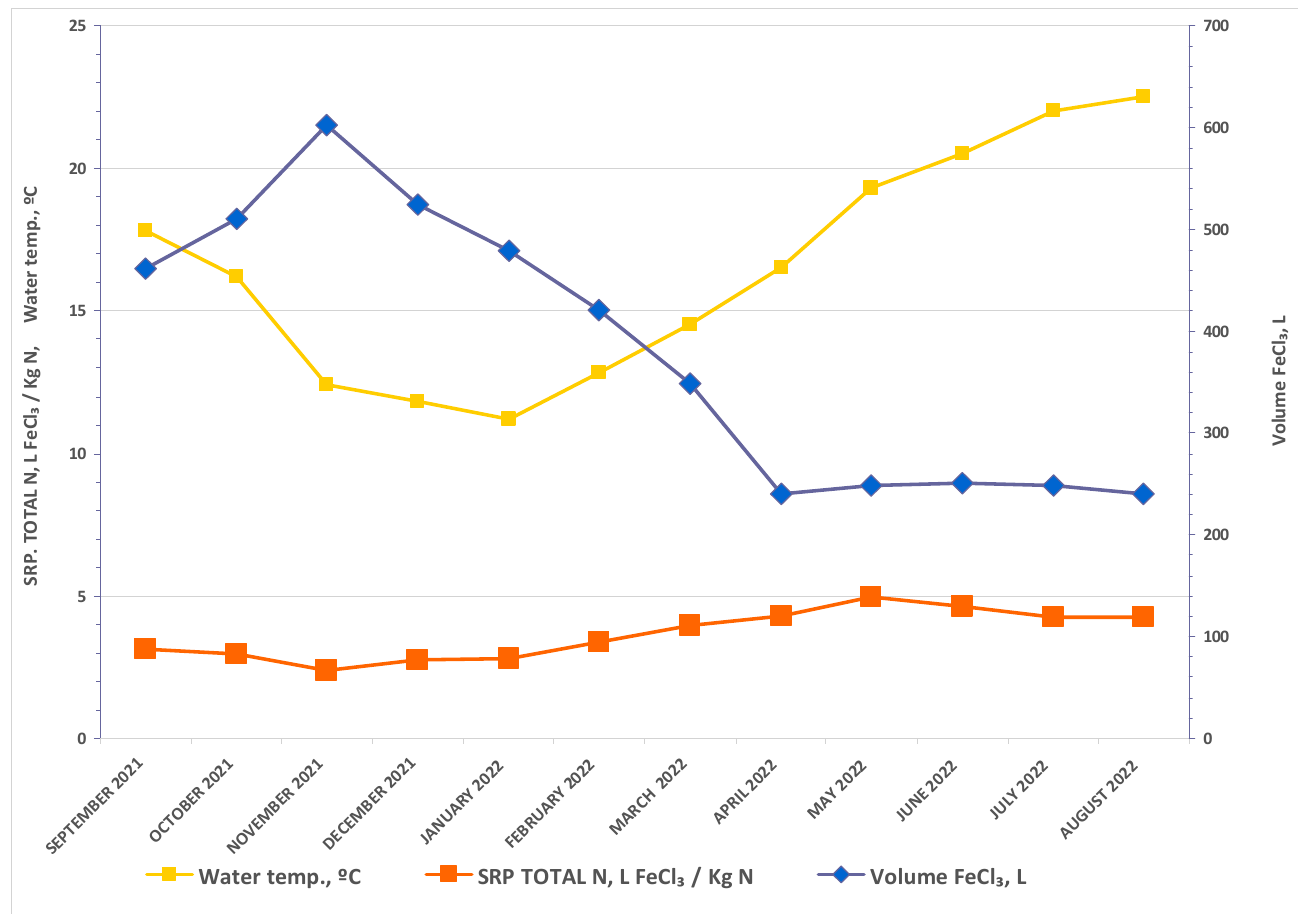
Figure 6. Seasonal variation in water temperature, SRP, and FeCl 3 consumption for the last 12 months (September 2021–August 2022). (September 2021–August